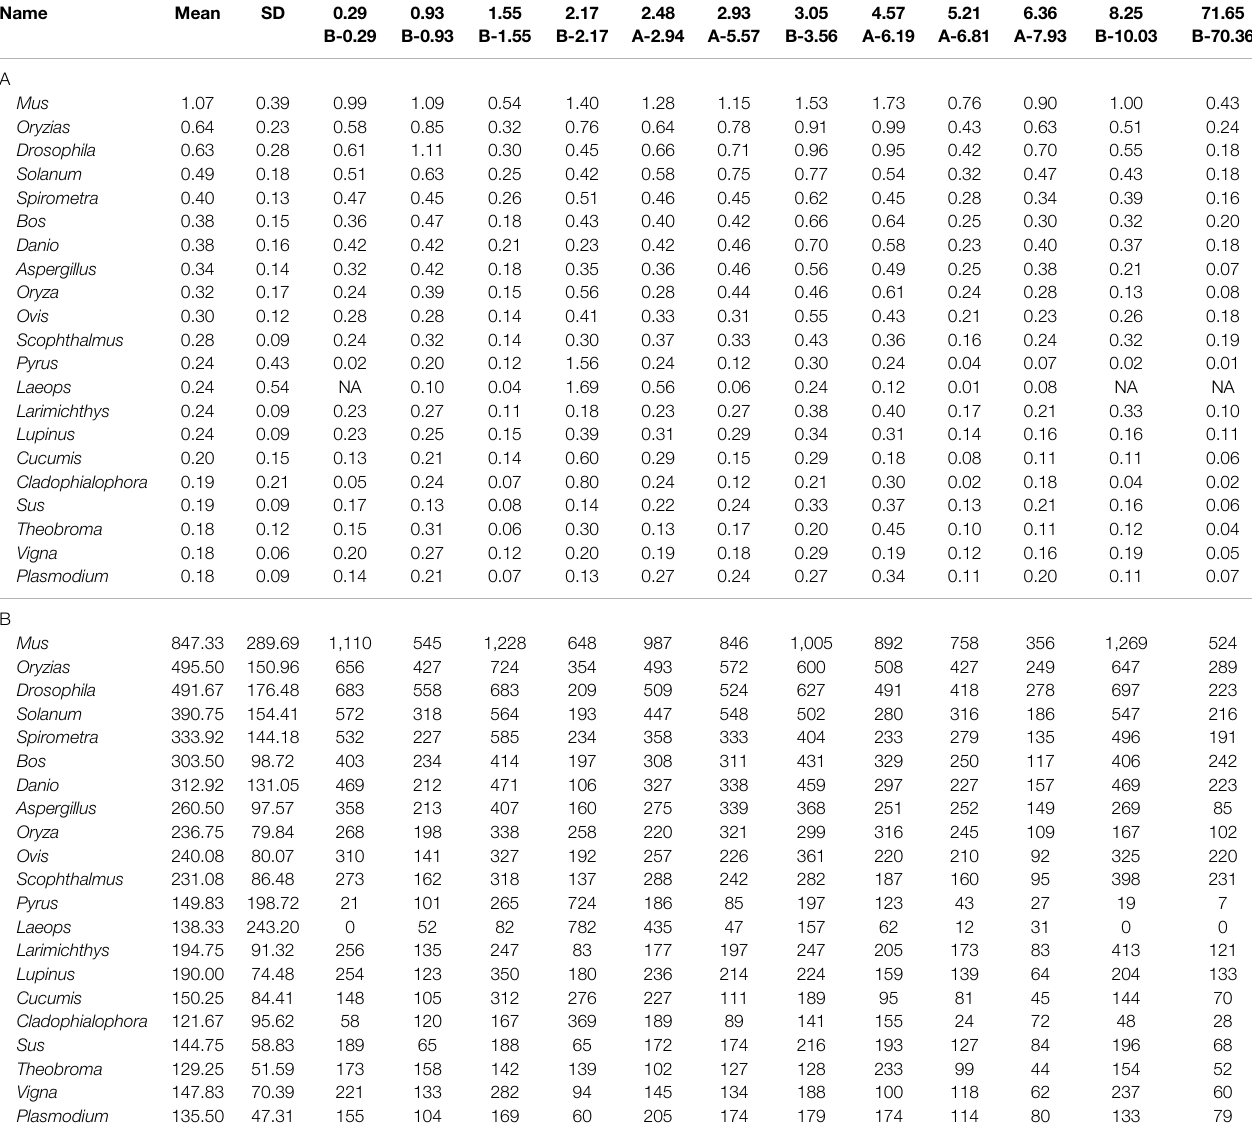
Relative abundances were calculated with the Pavian online tool. Sorted by mean value of each line. Panel A shows relative abundances (in %) of all reads that could be identi fi ed at the resolution of genus level. Panel B provides absolute read numbers. Samples are depicted by their depth (bold, in m) and their sample ID. Genera are ranked by mean values across samples. SD, standard deviation. The genera Cyprinus , Homo , Apteryx , and Notomacropus have been removed as likely contamination or artifacts (see text for